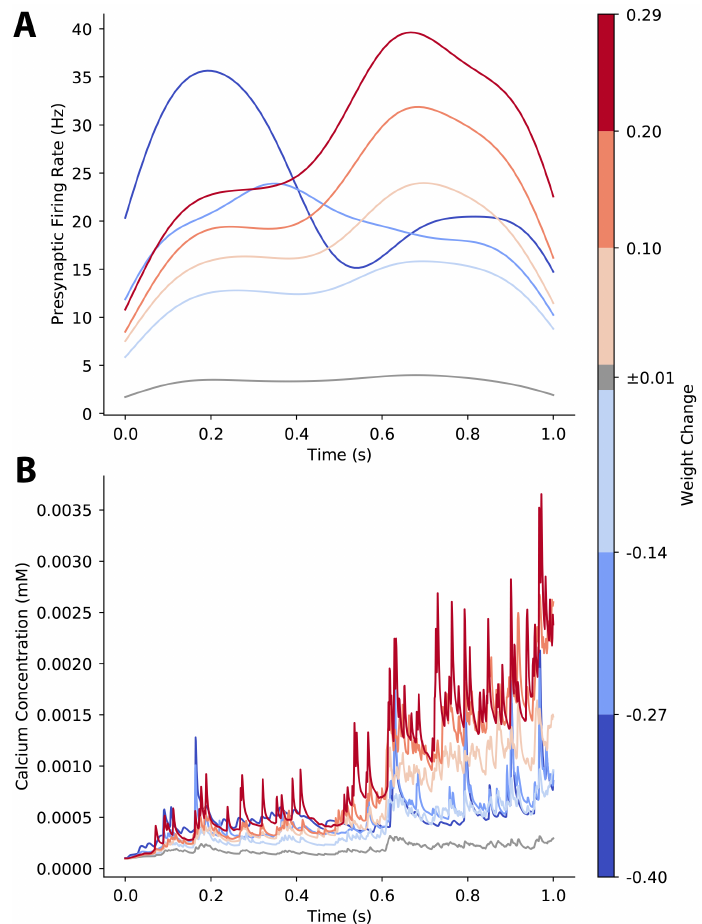
Figure 6. Temporal pattern determines direction of plasticity as shown by weight-change-triggered- average. ( A ) For each synapse on each trial, we computed the instantaneous firing rate of its pre-synaptic input activity and grouped synapse-trials into bins based on the size of the synaptic weight change that occurred following a single trial. Then, we averaged across the instantaneous firing rate of each bin. Late and high peak firing rates lead to LTP, while earlier peak firing rate or moderate firing rate leads to LTD. ( B ) For each synapse on each trial, we computed the calcium concentration for each synapse-trial and averaged across the calcium concentration for each weight change bin. Calcium concentration is higher during the second part of the trial, both for potentiating and depressing